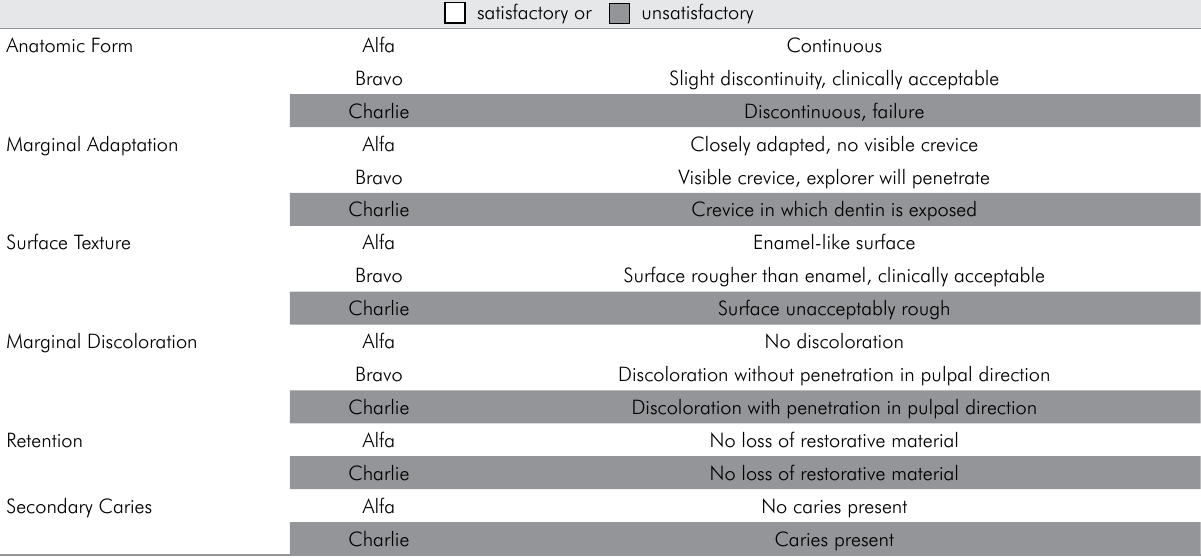
Table 1. United States Public Health Service USPHS-Modified classification